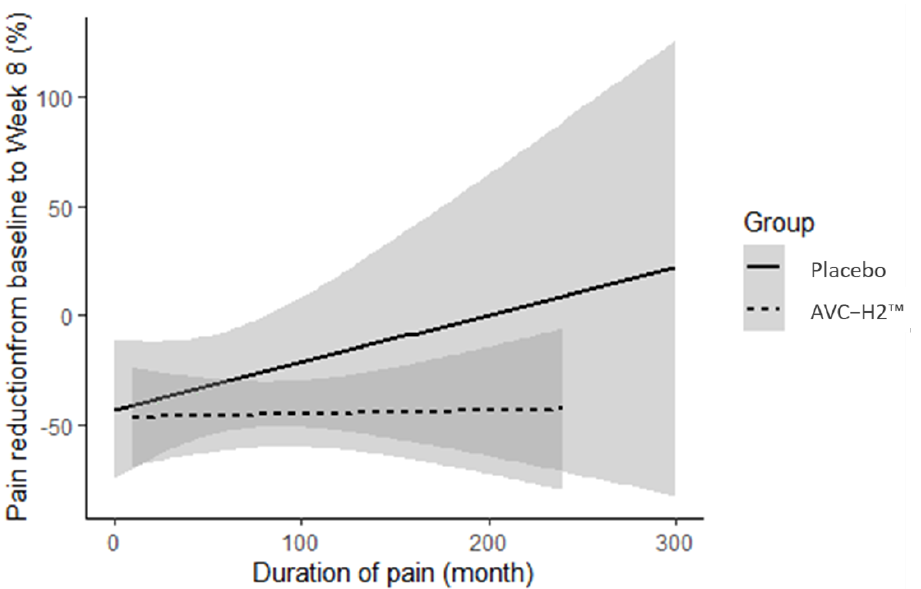
Figure 3. Pain reduction from the baseline to week 8 by duration of pain in the two groups. Duration of pain in months refers to how long the participants had experienced joint-related pain prior to enrollment in our study. Abbreviation: AVC-H2, Avicenna’s Hydrolyzed Chicken Collagen Type II.